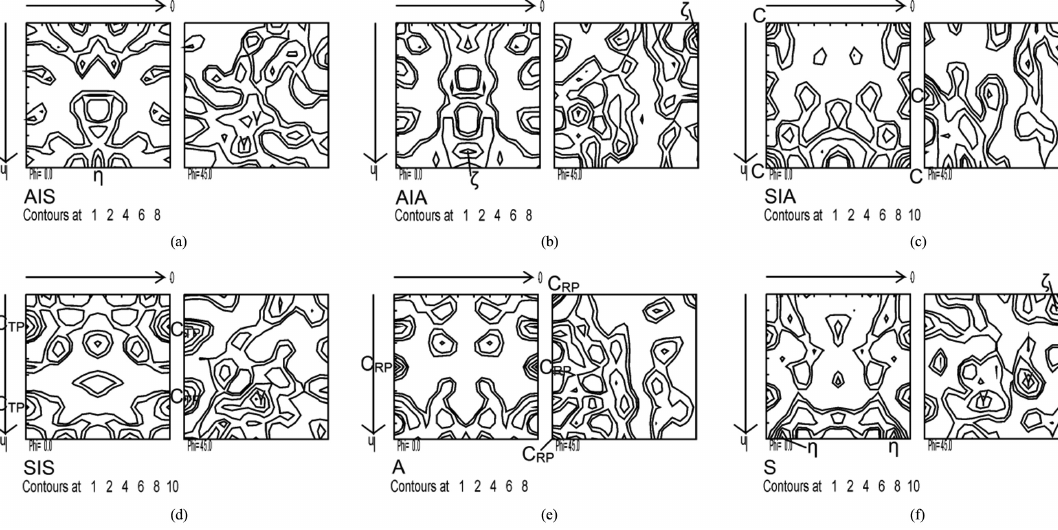
Figure 2. ODFs of final annealing texture of (a,d) symmetrical and (b,c) asymmetrical second cold rolling step samples, measured on half-thickness position, and of the one cold rolling step samples: (e) A and (f)